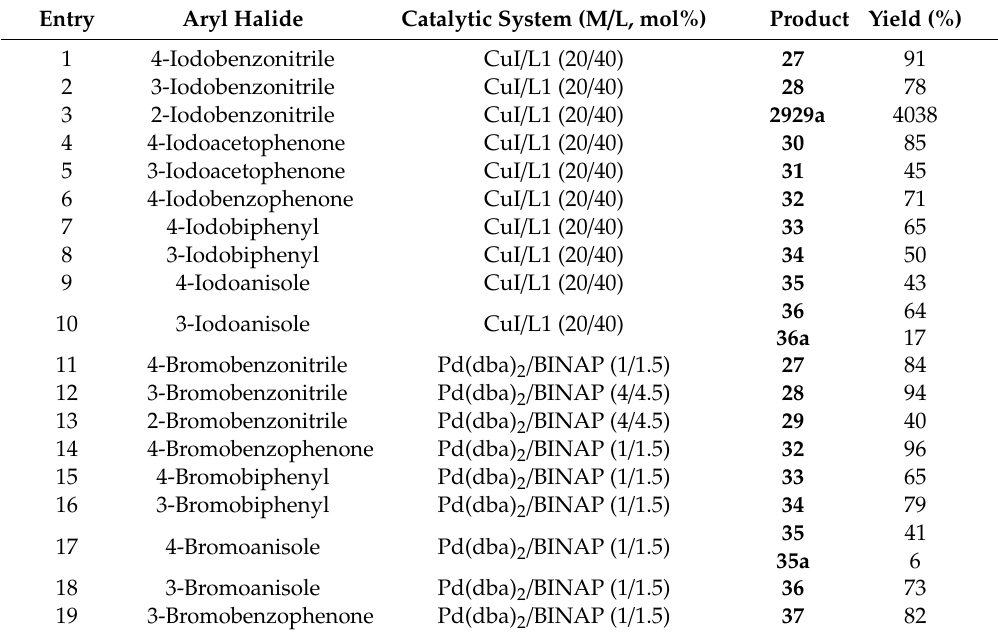
Table 3. Catalytic arylation of trioxadiamine 1 with various aryl iodides (CuI / L1, 20 / 40